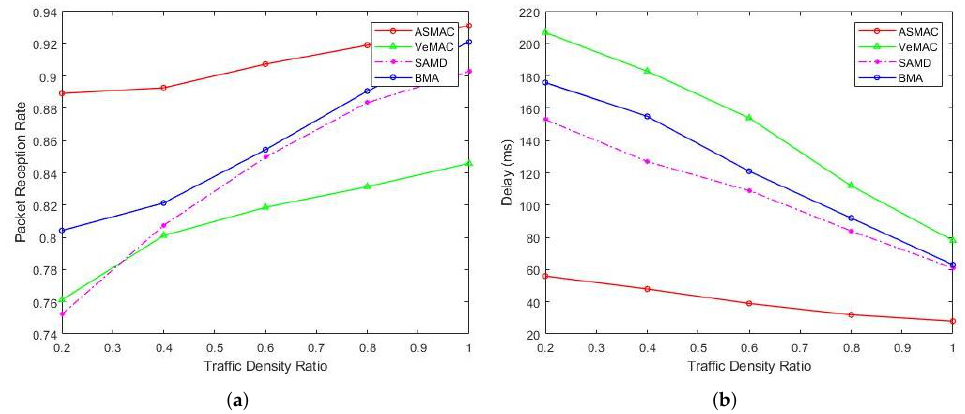
Figure 10. ( a ) Packet reception rate and ( b ) delay under different traffic density ratios when the number of vehicles is